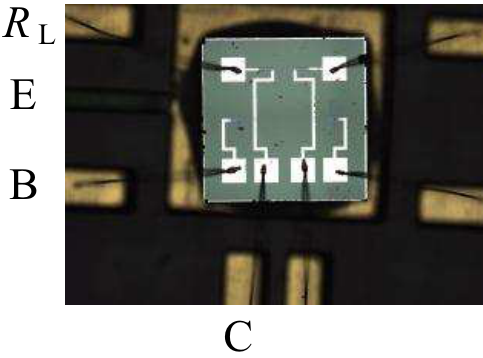
Figure 5. Packaging photograph of the integrated HSMST